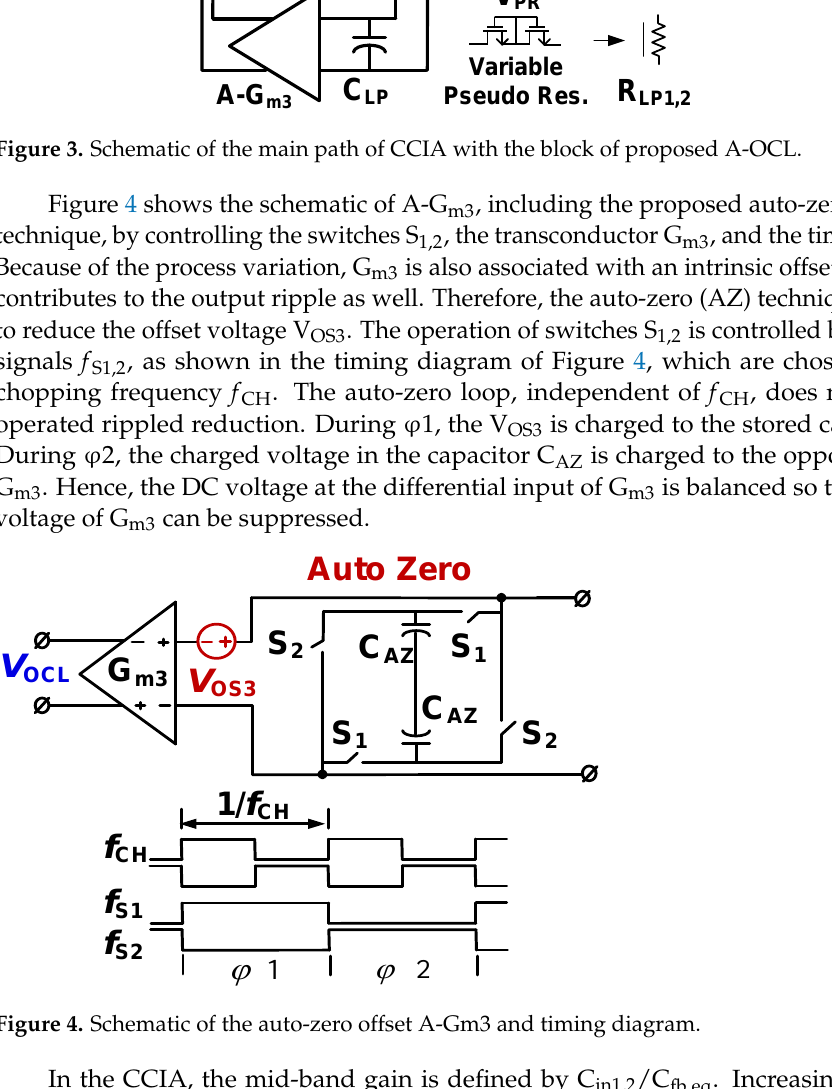
Figure 4. Schematic of the auto-zero offset A-G m3 and timing diagram.